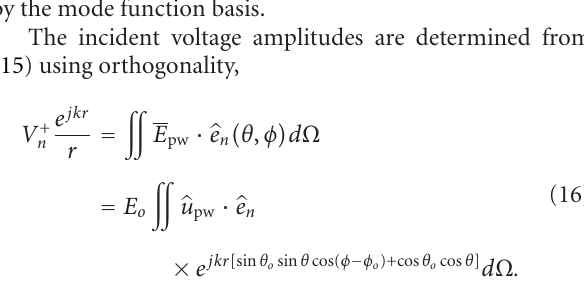
Figure 2: For the receiving case, an incident plane wave may be represented by a set of equivalent voltage sources, one for each